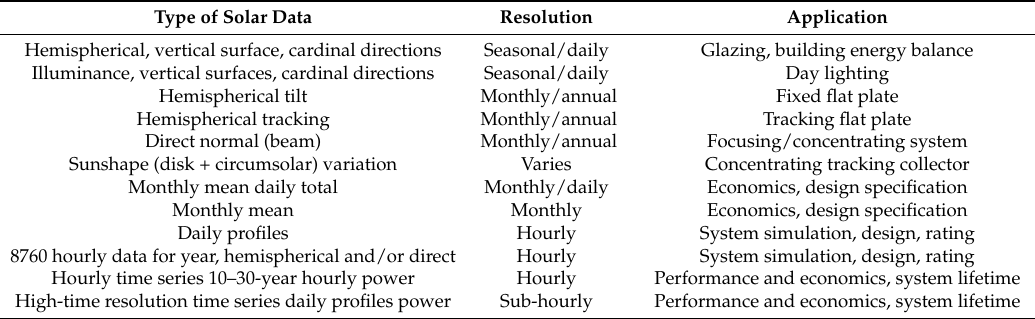
Table 2. Data format requested by solar designers